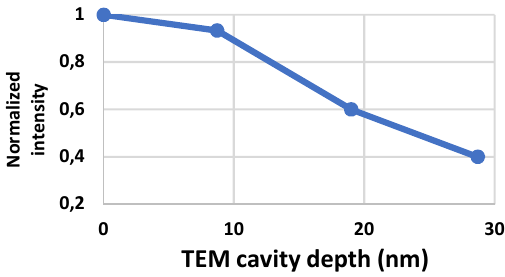
Figure 6 : Nanosheet structures (top) etched to various lateral depths and corresponding changes of the Ge 2p HAXPES curve intensities as measured with Cr K α radiation